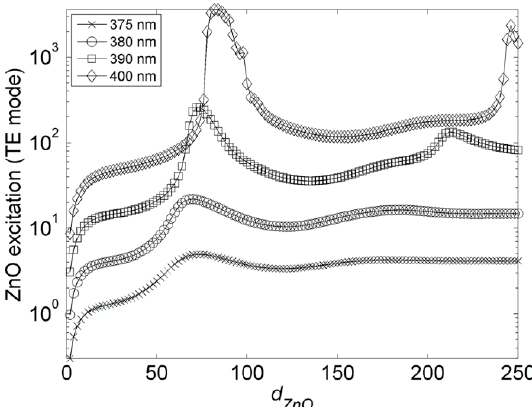
Figure 3. Evolution of the ZnO excitation as a function of the ZnO layer thickness ( d ZnO ) and emission wavelength. Graphs are shifted by half an order of magnitude and normalized to d ZnO = 0. Reprinted with permission from [18]. Copyright 2010 AIP Publishing